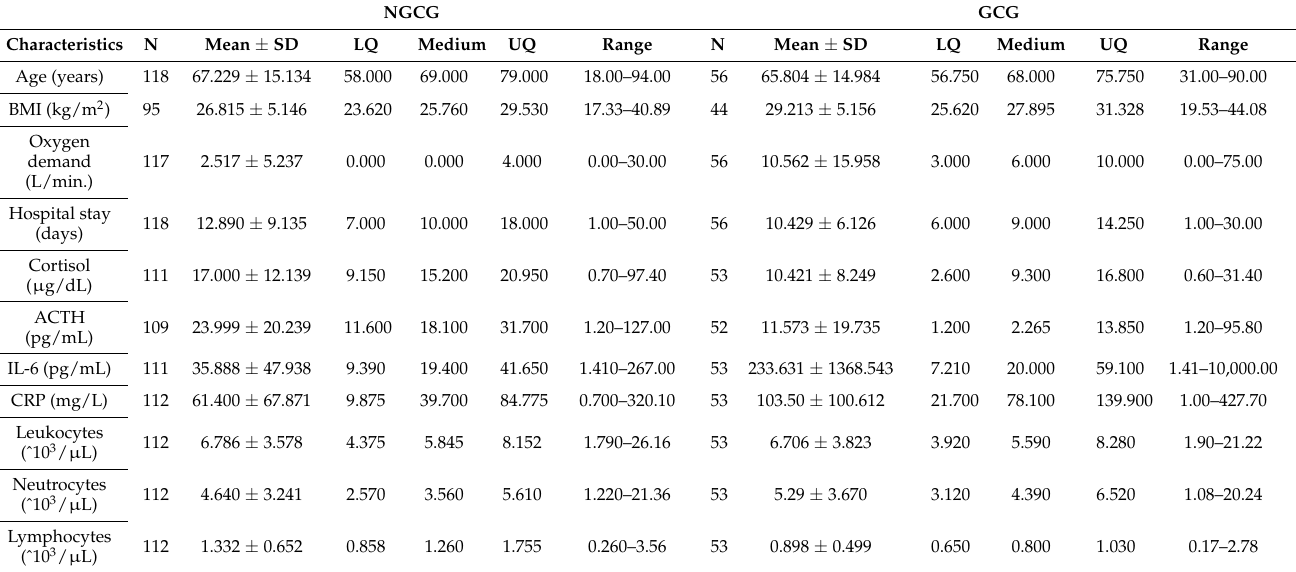
Table 1. Characteristics of the NGCG and the GCG at the time point #1. NGCG